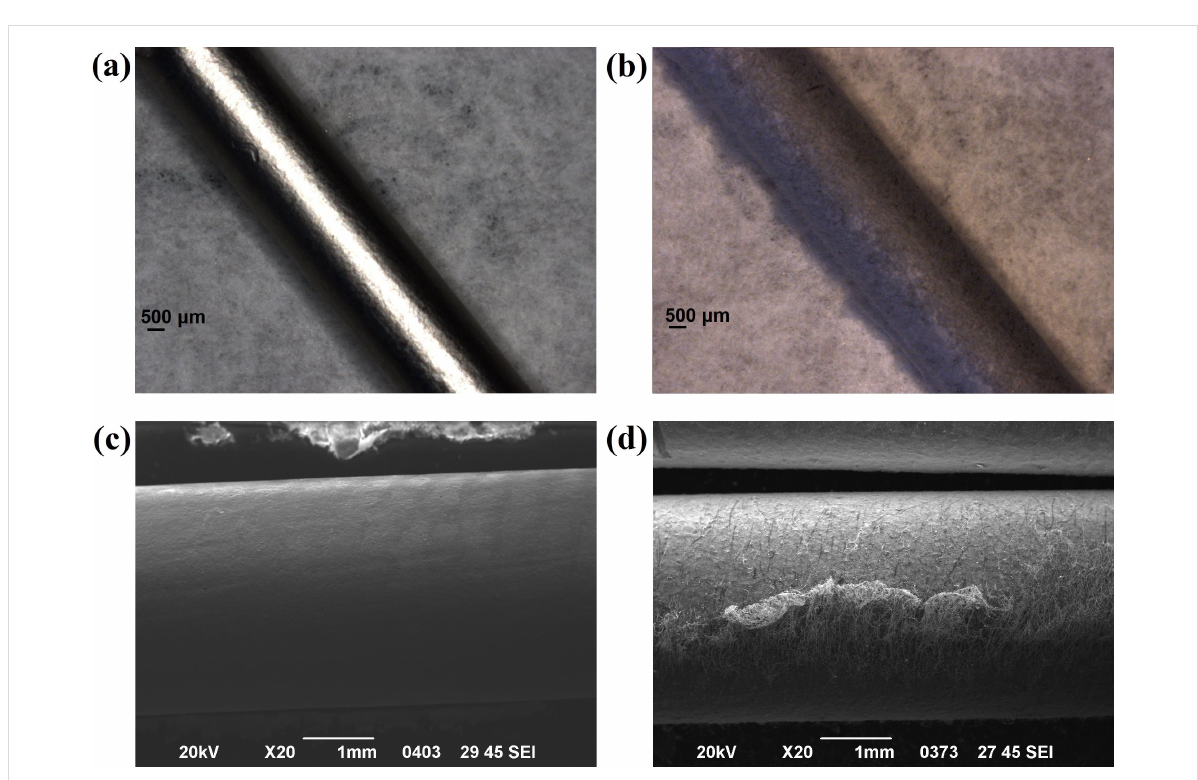
Figure 11: Keithley microscopy images of (a) a blank orthopedic pin, (b) a pin coated with CA:dexam fibers and SEM micrographs of (c) a blank orthopedic pin, (d) a pin coated with CA:dexam fibers.